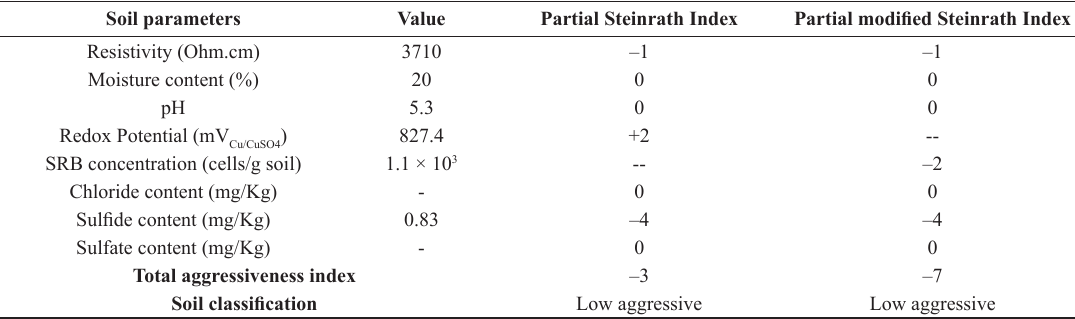
Figure 2. Profile of the electric resistivity vs moisture content. Table 1. Classification of corrosivity - Steinrath